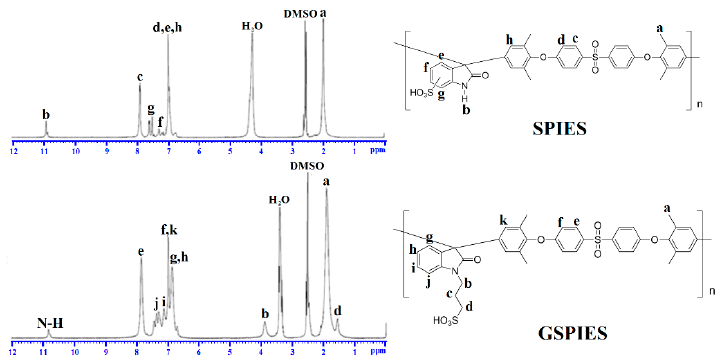
Figure 3. 1 H NMR of sulfonated poly(isatin-ethersulfone) (SPIES) and grafting sulfonated poly(isatin- ethersulfone) (GSPIES).